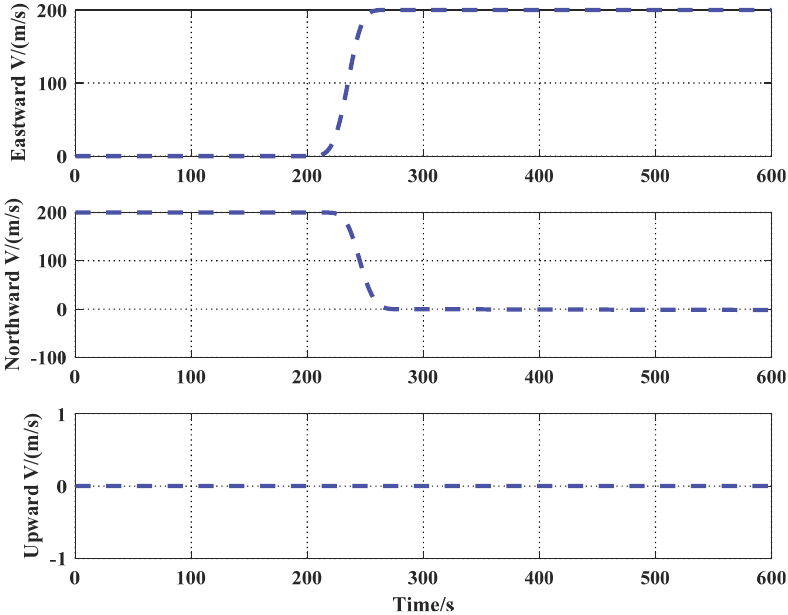
Figure 3. Velocity of UAV. The initial attitude error was (0.5m / s 0.5m / s 0.5m / s) and initial position error was (20m 20m 20m) .The bias and standard deviation of the white noise of the accelerometer were 800 g 100 g